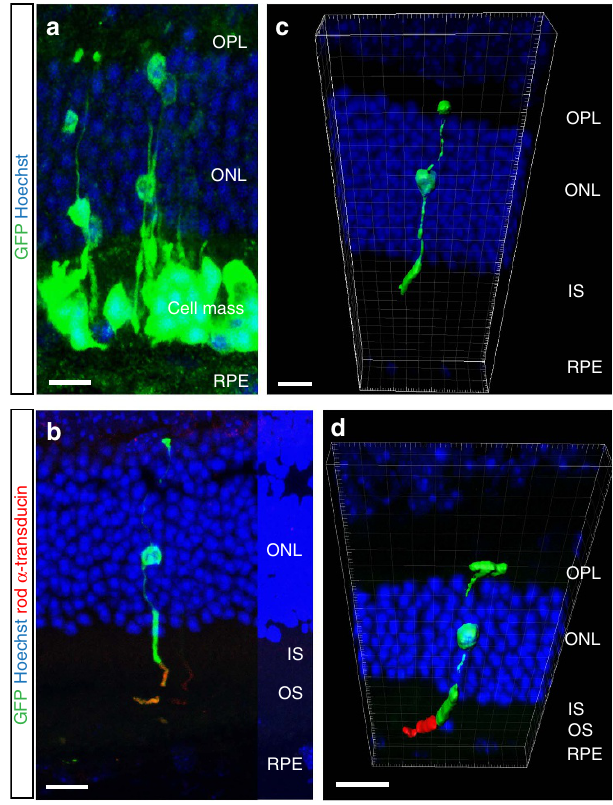
Figure 8 | Material transfer does not require sustained physical interaction between donor and host cells. ( a ), confocal image of GFP þ cells within the host ONL immediately below the donor cell mass. Labelled user segments terminate close to the cell mass. ( b ), confocal image